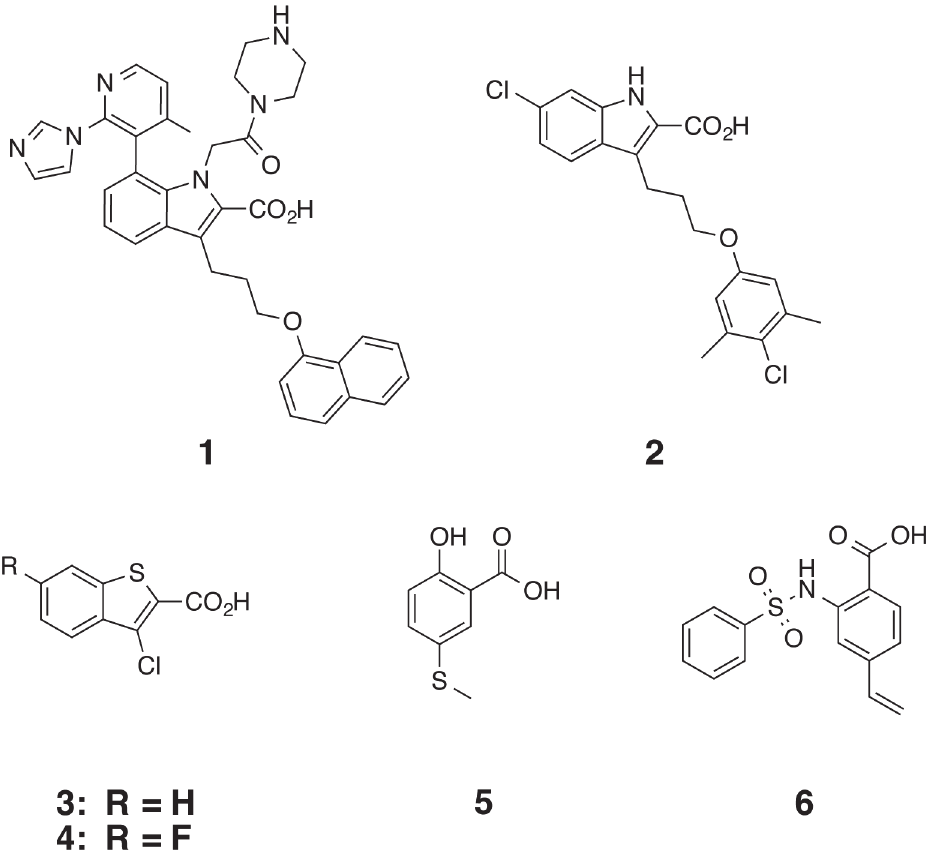
Fig 1. MCL1 ligands used in co-crystallization